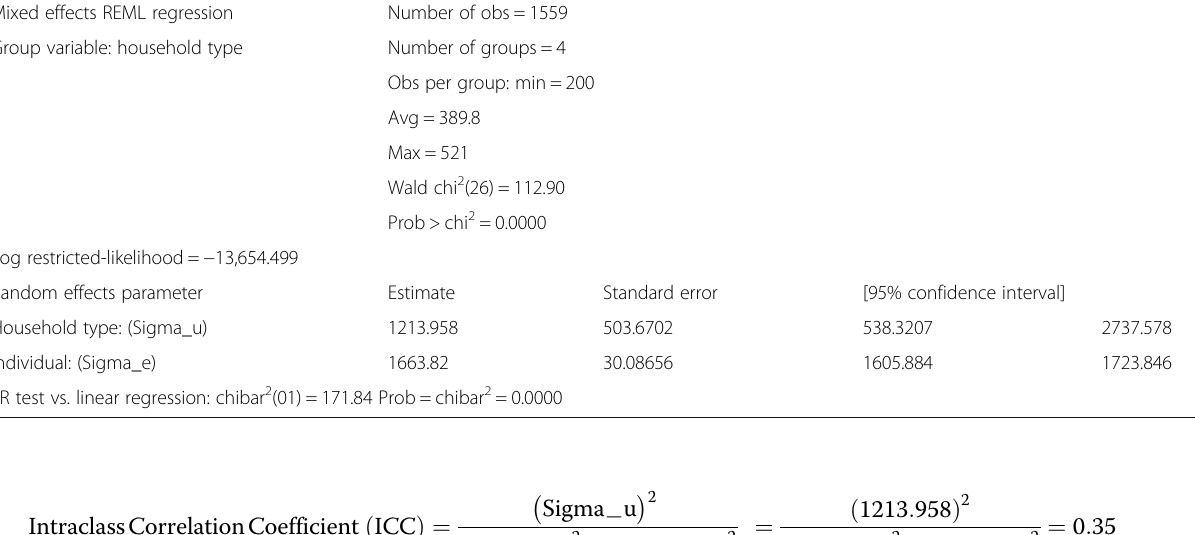
Table 7 Mixed OLS-random effects test Mixed effects REML regression